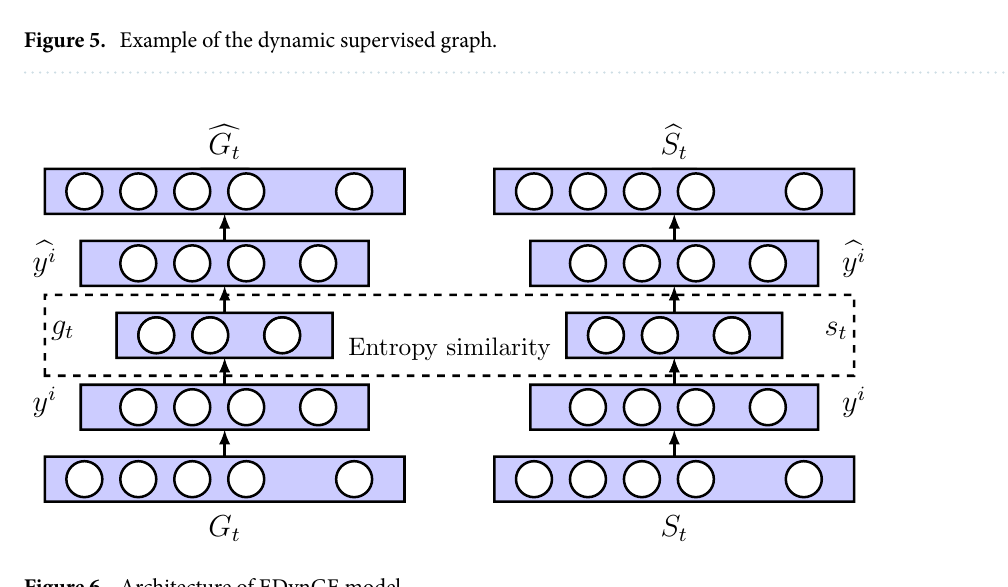
Figure 6. Architecture of EDynGE